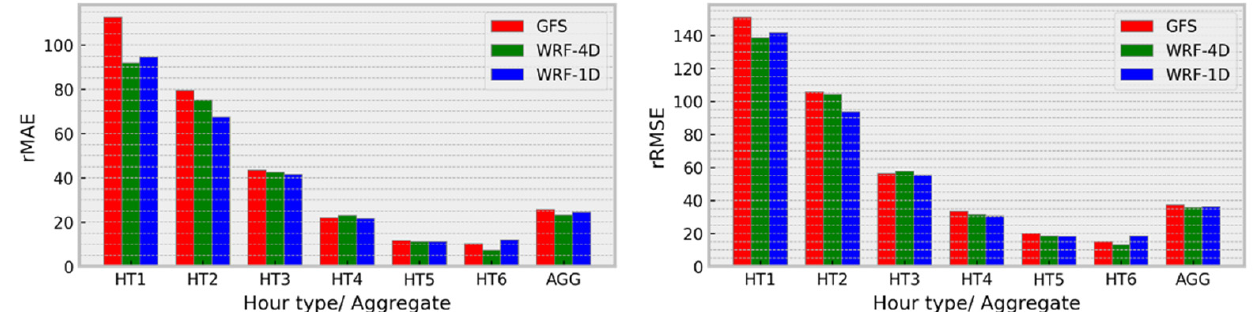
Figure 3. Variation of rMAE and rRMSE for different hour types and overall aggregate for the duration.